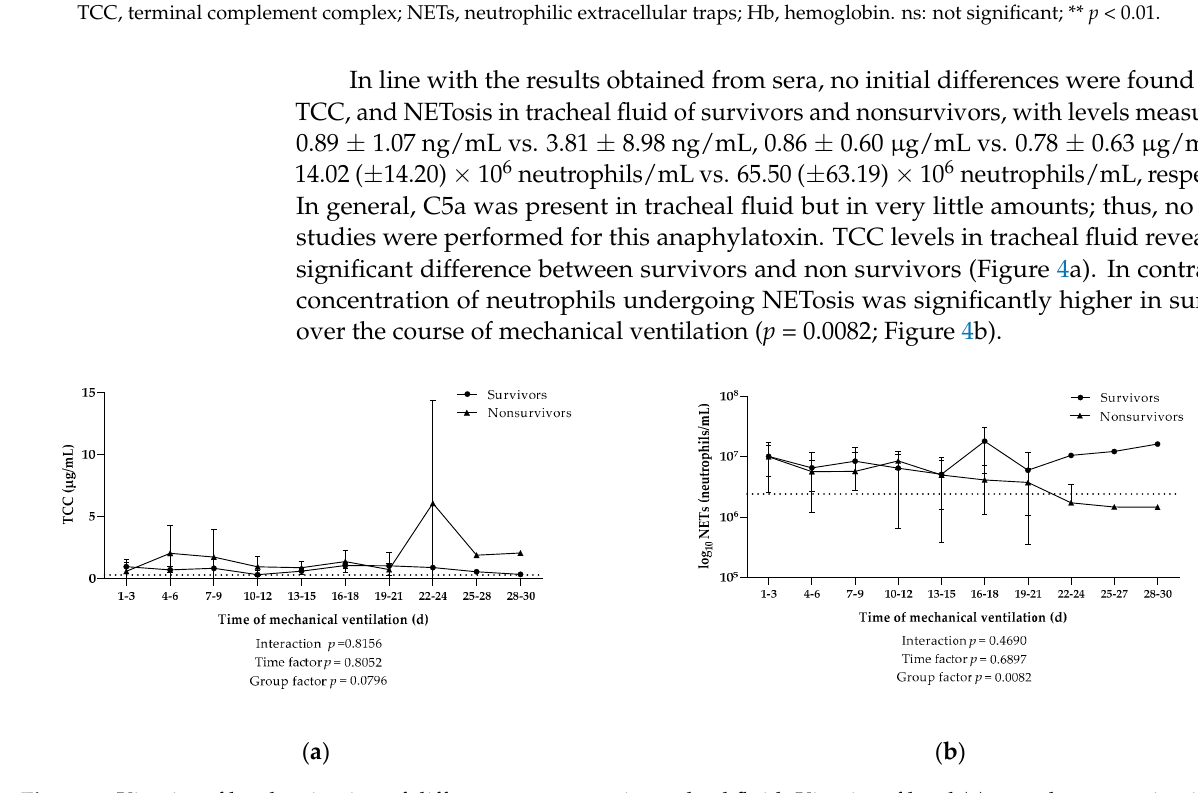
Figure 4. Kinetics of local activation of different parameters in tracheal fluid. Kinetics of local ( a ) complement activation characterized by the terminal complement complex (TCC) and ( b ) the release of NETs from neutrophils measured during the course of mechanical ventilation in COVID-19 patients that survived ( n = 4) or died ( n = 7). Data are shown as mean ± SD. Dotted lines indicate the mean value in the control group. p -Values were calculated by linear mixed model of clustered log-transformed